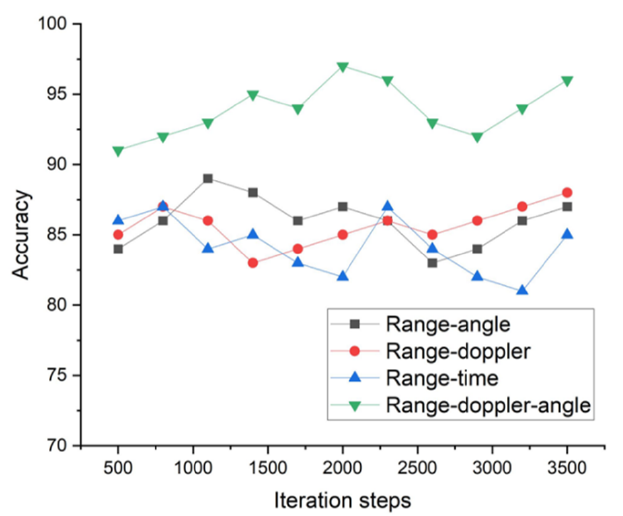
Figure 20. Characteristic comparison diagram.